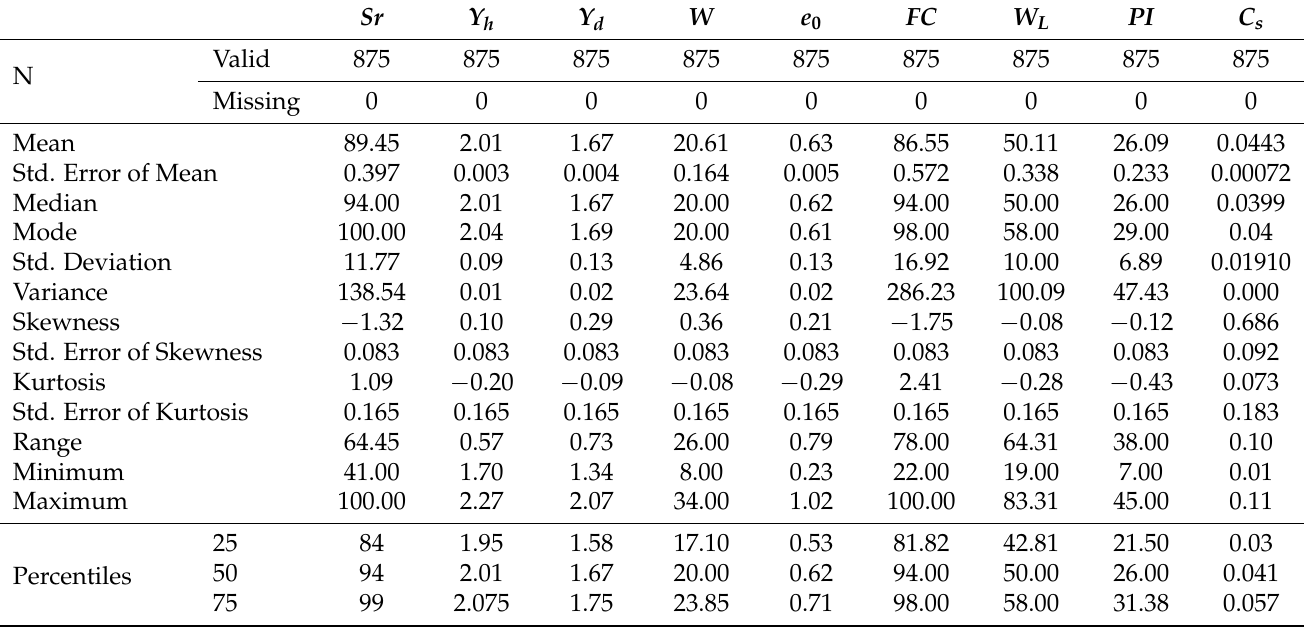
Table 4. Descriptive statistics of collected samples.